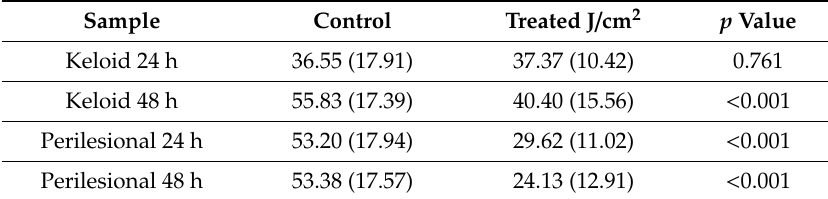
Table 3. Pooled data of cell viability in keloid and perilesional fibroblasts (mean ± SD) in control and treated cell cultures, and the relative p -values resulting from the unpaired t